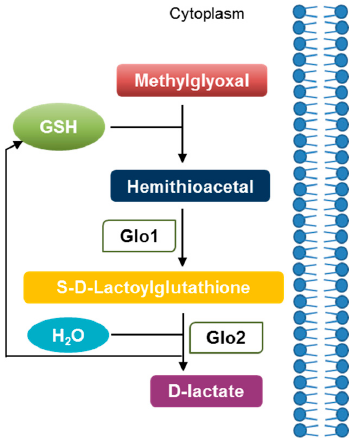
Figure 3. The glyoxalase system. The glyoxalase system consists of glyoxalase 1 (Glo1), glyoxalase 2 (Glo2), and a catalytic amount of glutathione (GSH). Acting as the rate-limiting enzyme, Glo1 transforms the hemithioacetal spontaneously formed between MG and GSH to the thioester S- D -lactoylglutathione. In turn, Glo2 catalyzes the hydrolysis of S- D -lactoylglutathione to D -lactate regenerating GSH.